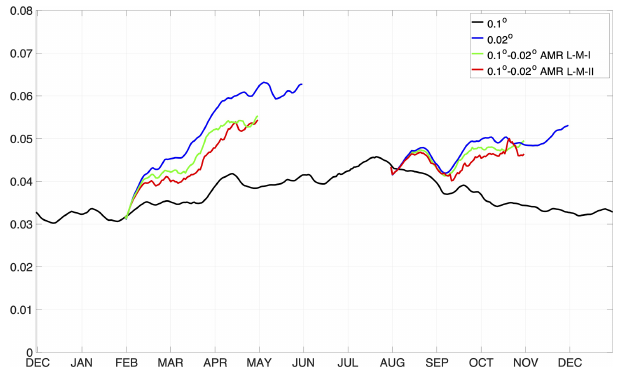
Figure 9. Surface mean kinetic energy (m − 2 s − 2 ) in 0.02 ◦ experi- ments and the associated 0.1 ◦